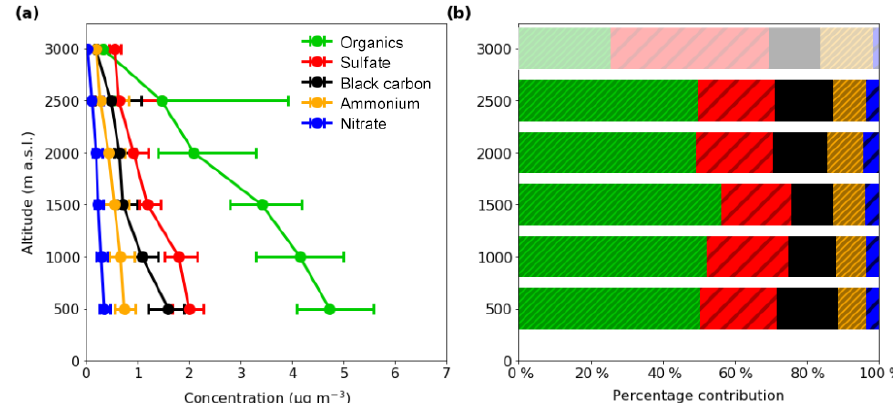
Figure 2. (a) Average chemical composition of aerosol in the Savè region, as measured by the AMS and SP2 (black carbon). Results are displayed at standard temperature and pressure (STP) and altitude is above sea level (a.s.l.) The centre point indicates the median concentration and the bars the lower and upper quartiles. (b) The percentage contribution of each chemical species in each altitude bin. The 3000m is shaded as data only exist at this altitude from 1h on 15